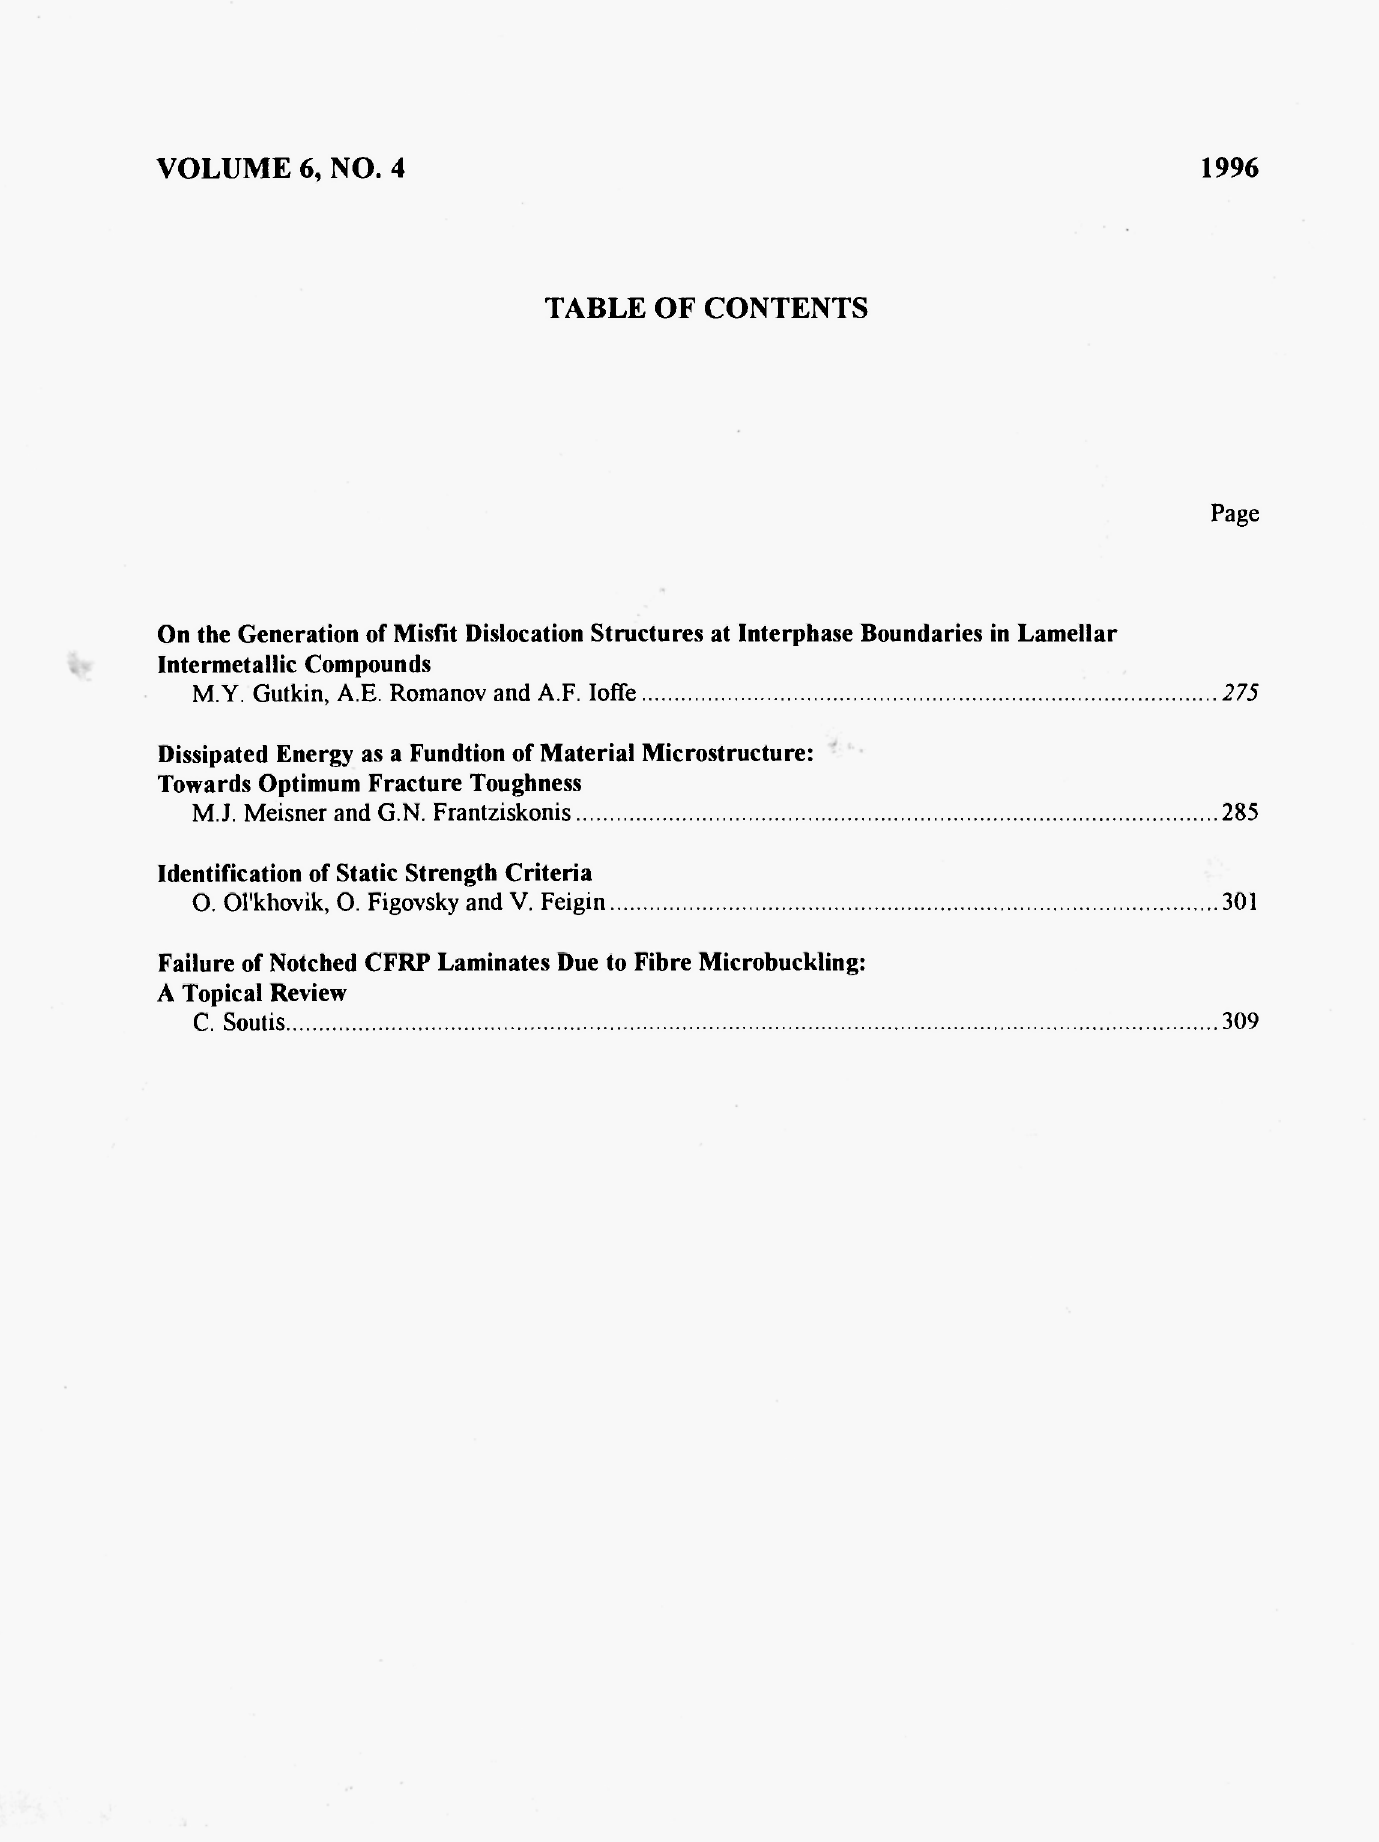
On the Generation of Misfit Dislocation Structures at Interphase Boundaries in Lamellar Intermetallic Compounds MY. Gutkin, A.E. Romanov and A.F. Ioffe 275 Dissipated Energy as a Fundtion of Material Microstructure: Towards Optimum Fracture Toughness